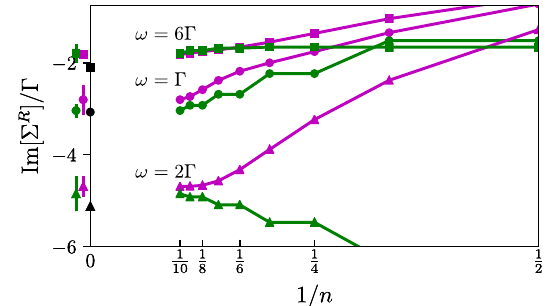
FIG. 8. Resummation of the self-energy in the equilibrium symmetric Anderson impurity model at U ¼ 9 Γ . The imaginary part of Σ R ð ω Þ is shown as a function of the number n of terms kept in the resummation, for three frequencies ω ¼ Γ (circles), 2 Γ (triangles), and 6 Γ (squares). The independent resummations of F ω ð U Þ (green line) and of Σ R ð ω Þ − i Γ (purple line) converge with one another. The results with truncation and statistical errors are shown on the left of the y axis, along with NRG results (black